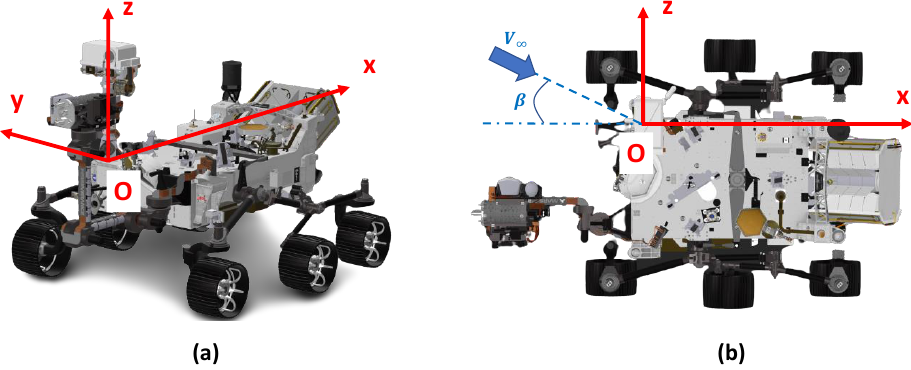
Figure 3. ( a ) Isometric view of the Mars rover Perseverance with its coordinate axes OXYZ; ( b ) plan view of the Mars rover Perseverance , and definition of the slip angle [16].